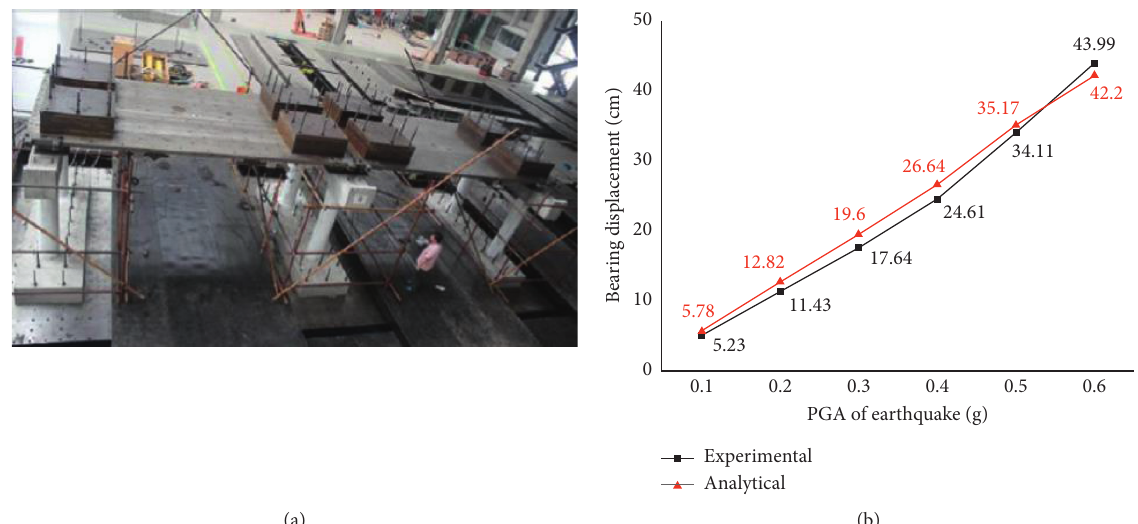
Figure 5: Picture of model and results: (a) shaking table test of the experimental model [26] and (b) bearing displacement under Northridge earthquakes with increasing